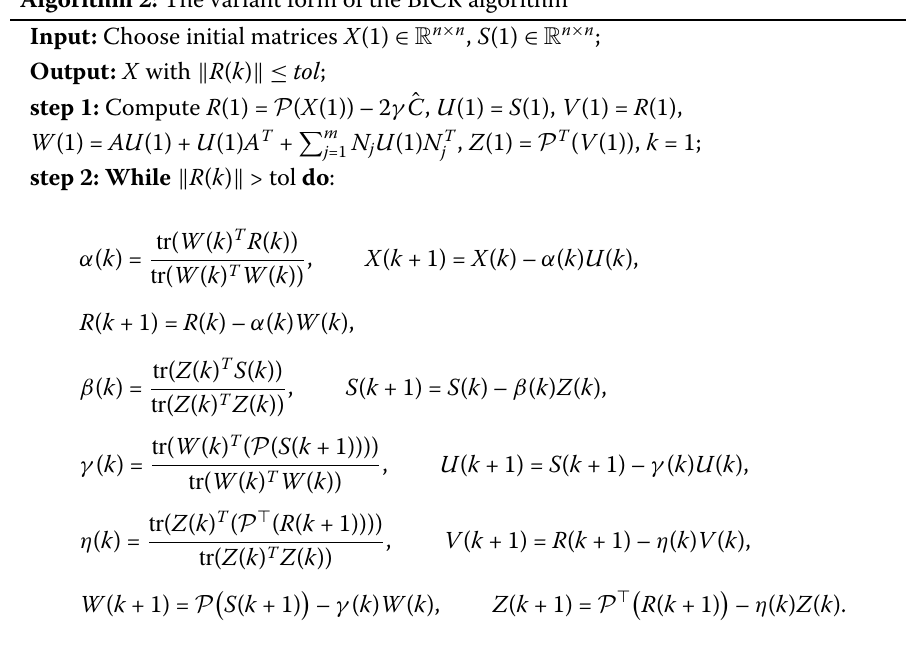
Algorithm 2: The variant form of the BICR